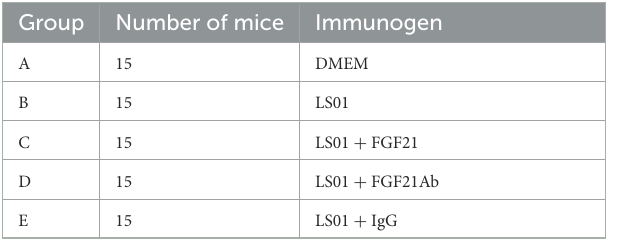
TABLE 1 BVD mouse model construction.